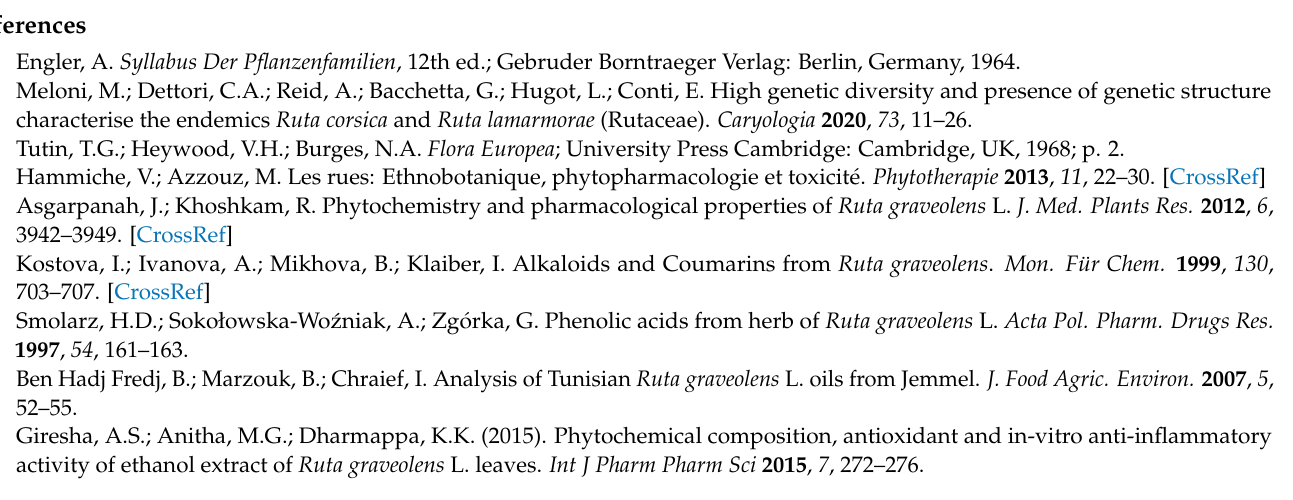
cultures; Figure S2: Sample chromatogram of the extract from Ruta chalepensis in vitro cultures; Figure S3: Sample chromatogram of the extract from Ruta graveolens in vitro